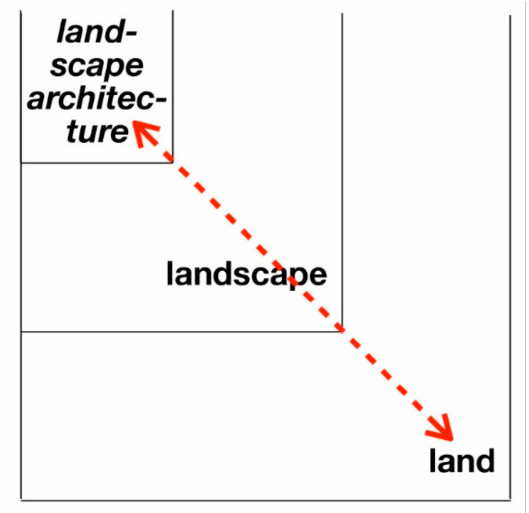
Figure 1. All fieldwork takes into account the relations between land, landscape, and landscape architecture in sites, landscapes, and projects